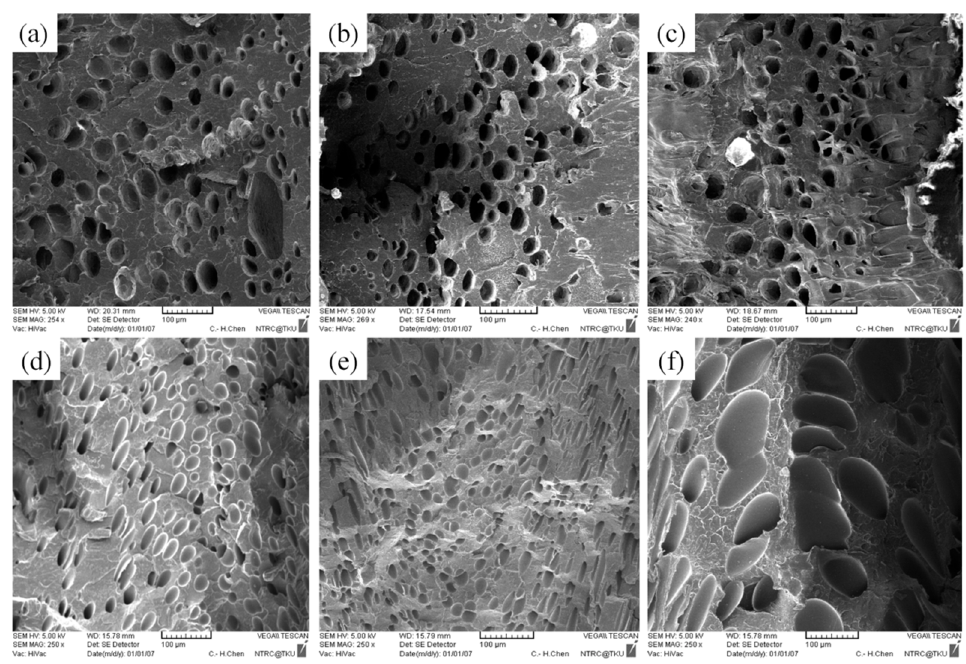
Figure 8. SEM micrographs of PP processed with different injection speeds: ( a ) 80 cm 3 /s, ( b ) 100 cm 3 /s, ( c ) 120 cm 3 /s; SEM